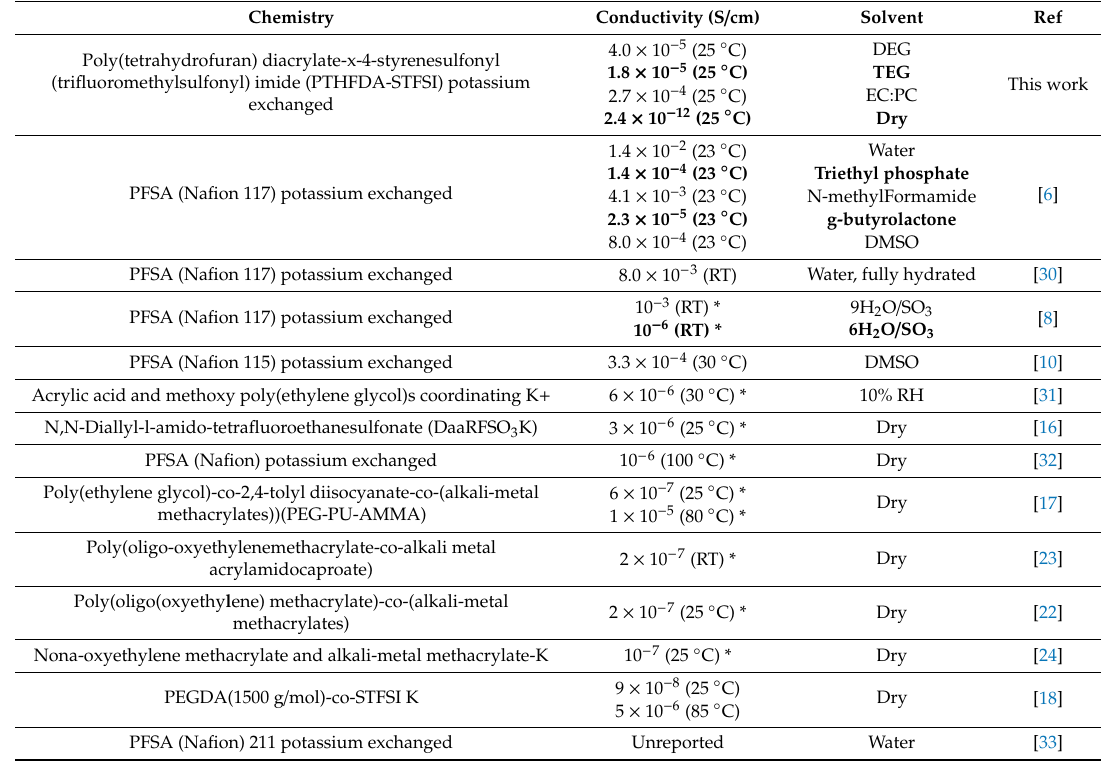
Table 2. Conductivity of potassium exchanged single-ion conducting polymers reported in the literature. * denotes value was estimated by visual inspection of plot. Bolded font is for visual guidance.